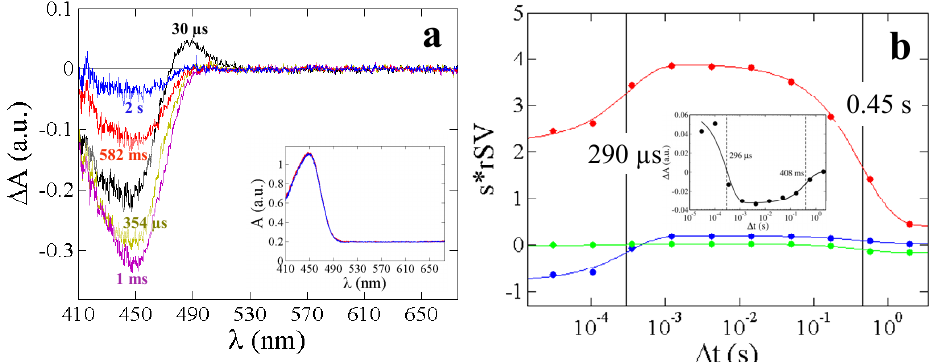
Figure 5. ( a ) Time-resolved difference absorption spectra from 30 µs to 2 s shown for PYP in solution at 295 K. Black spectrum: earliest time point; Blue spectrum: last time point. The inset shows the dark spectra collected before (red) and after (blue) the full time-series. No permanent bleaching has occurred; ( b ) Two significant rSVs obtained from the singular value decomposition (SVD) analysis of the spectral changes from 400 nm to 510 nm: 1st rSV (red solid circles); 2nd rSV (blue solid circles); 3rd rSV (green solid circles). Global fitting of the 1st, 2nd, and 3rd rSV are represented by red, blue, and green curves, respectively, and relaxation times are shown as vertical lines. Insert: time-series observed at a single wavelength. Spheres: difference absorption at λ = 485 nm, solid line: fit with sum of two exponentials, relaxation times are consistent with those from the SVD